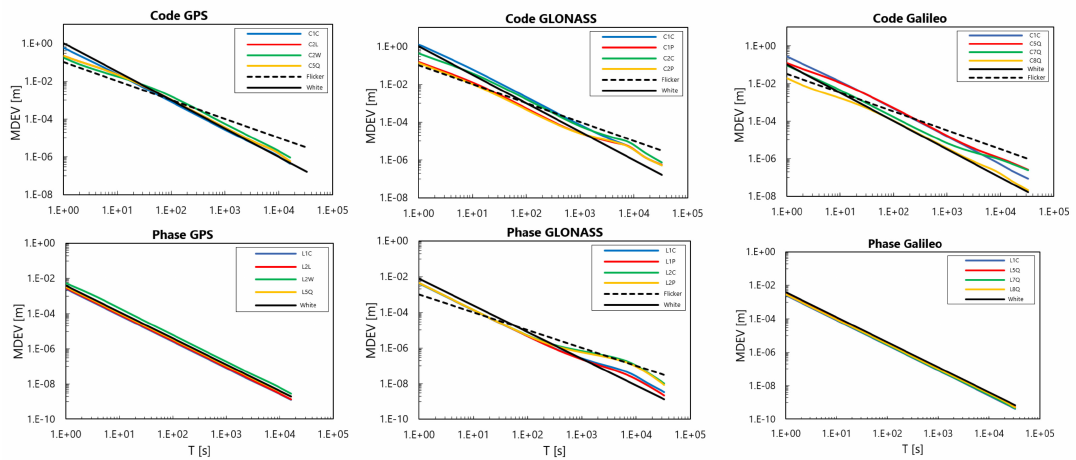
Figure 15. Averaged MDEV for each system along with the types of noise fitted to